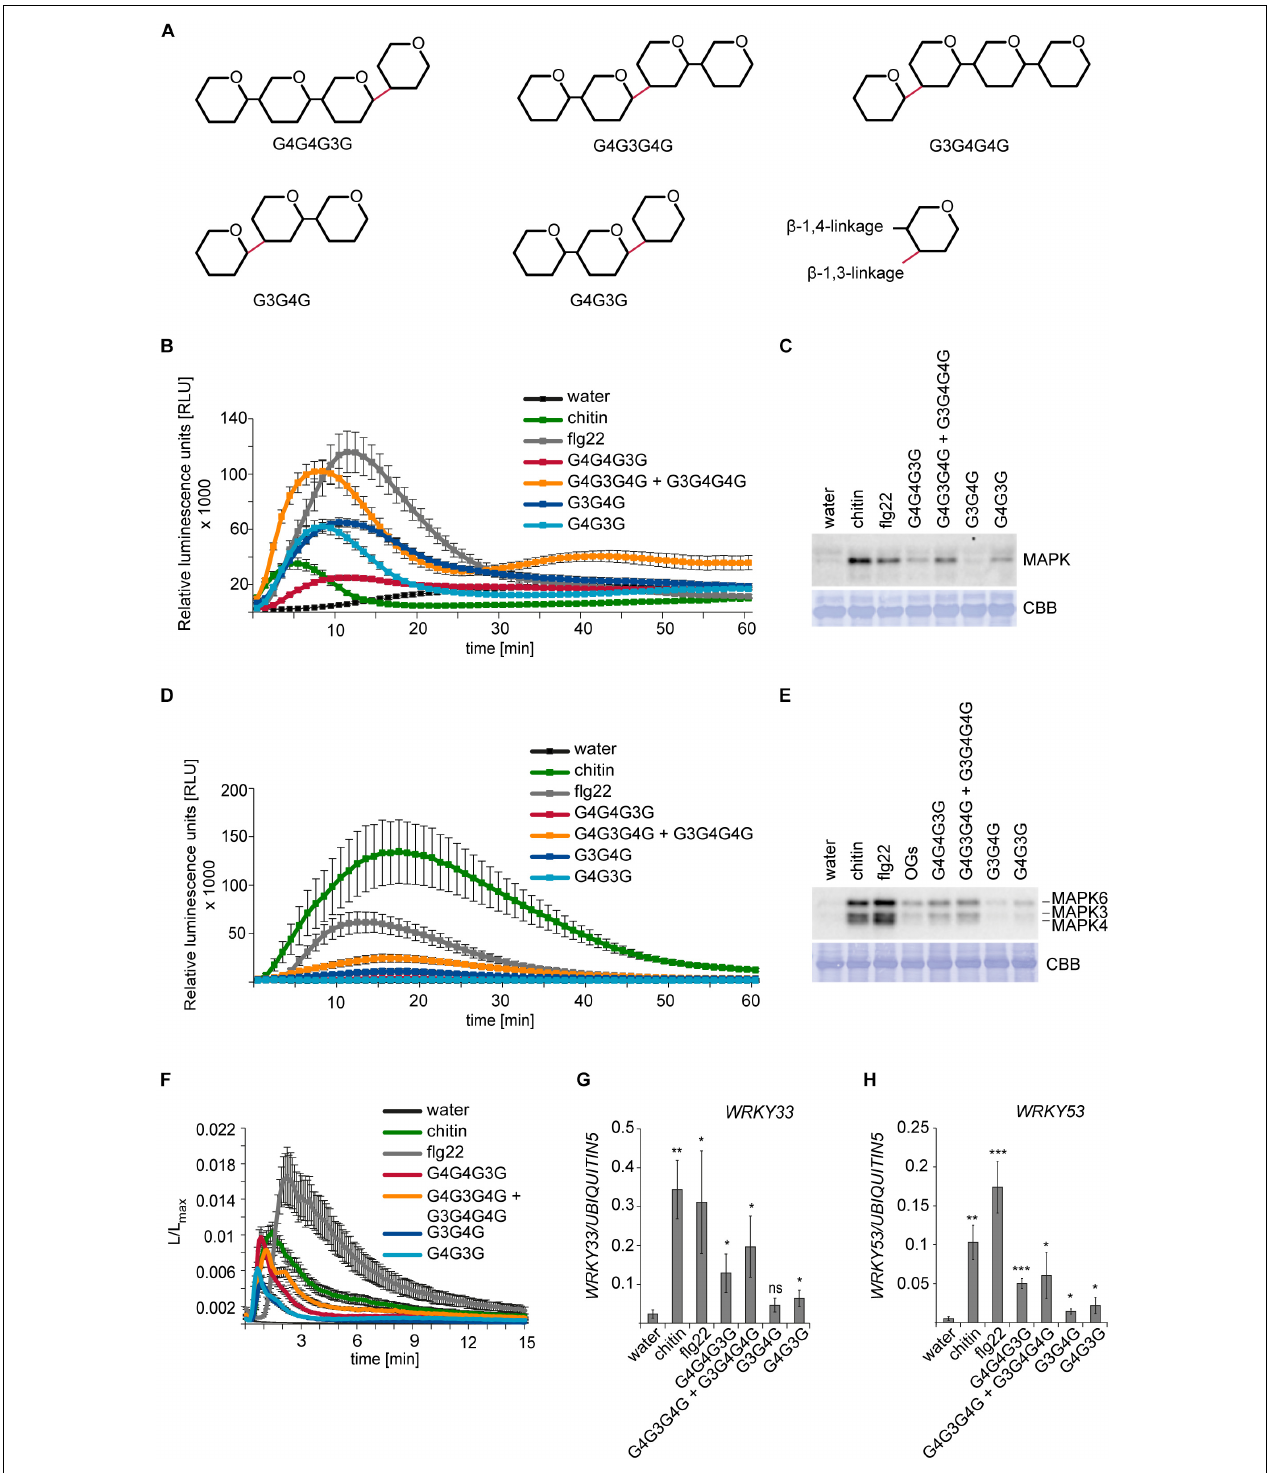
FIGURE 2 | Activation of PTI in H. vulgare and A. thaliana by β -1,3/1,4-MLG tetrasaccharides and trisaccharides. For ROS production and calcium elevation, 150 µ M of the β -1,3/1,4-MLG tetrasaccharides and 190 µ M of the β -1,3/1,4-MLG trisaccharides were used. Water, chitin (100 µ g ml - 1 ) and flg22 (100 nM) served as controls. For MAPK activation and calcium elevation, 15 µ M and 19 µ M of the β -1,3/1,4-MLG tetrasaccharides and β -1,3/1,4-MLG trisaccharides were used, respectively. As controls, water, chitin (10 µ g ml − 1 ) and flg22 (50 nM) and oligogalacturonides (OG; 10 µ g ml − 1 ) were used. (A) Structure of the β -1,3/1,4-MLG MLG tetrasaccharides and -trisaccharides used in the experiments. (B) ROS production in leaf discs of 12–14-days old H. vulgare plants upon elicitation with